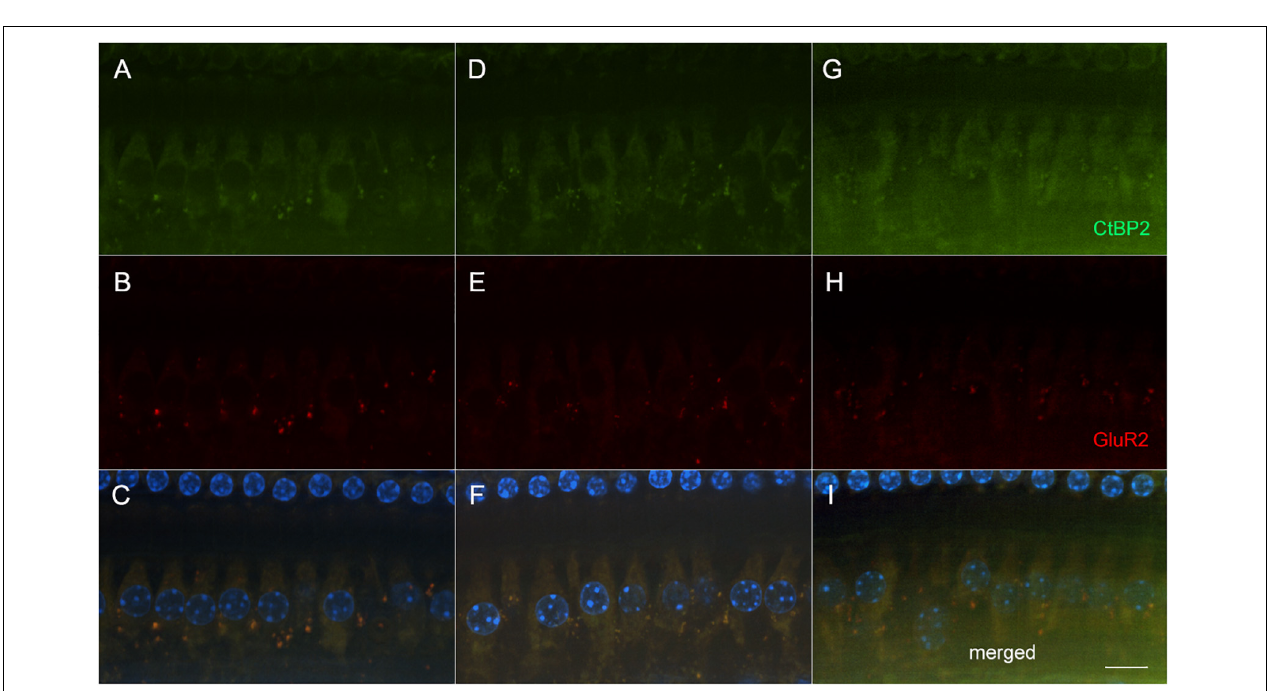
FIGURE 3 | Representative whole mount cochlear images displaying cochlear hair cells for both treatment groups ( A: amikacin and B: amikacin/ebselen). No observable evidence of amikacin-induced OHC (stained with anti-Prestin antibody, green) or IHC (stained with anti-Calretinin antibody, red) loss. Scale bar = 100 mm.